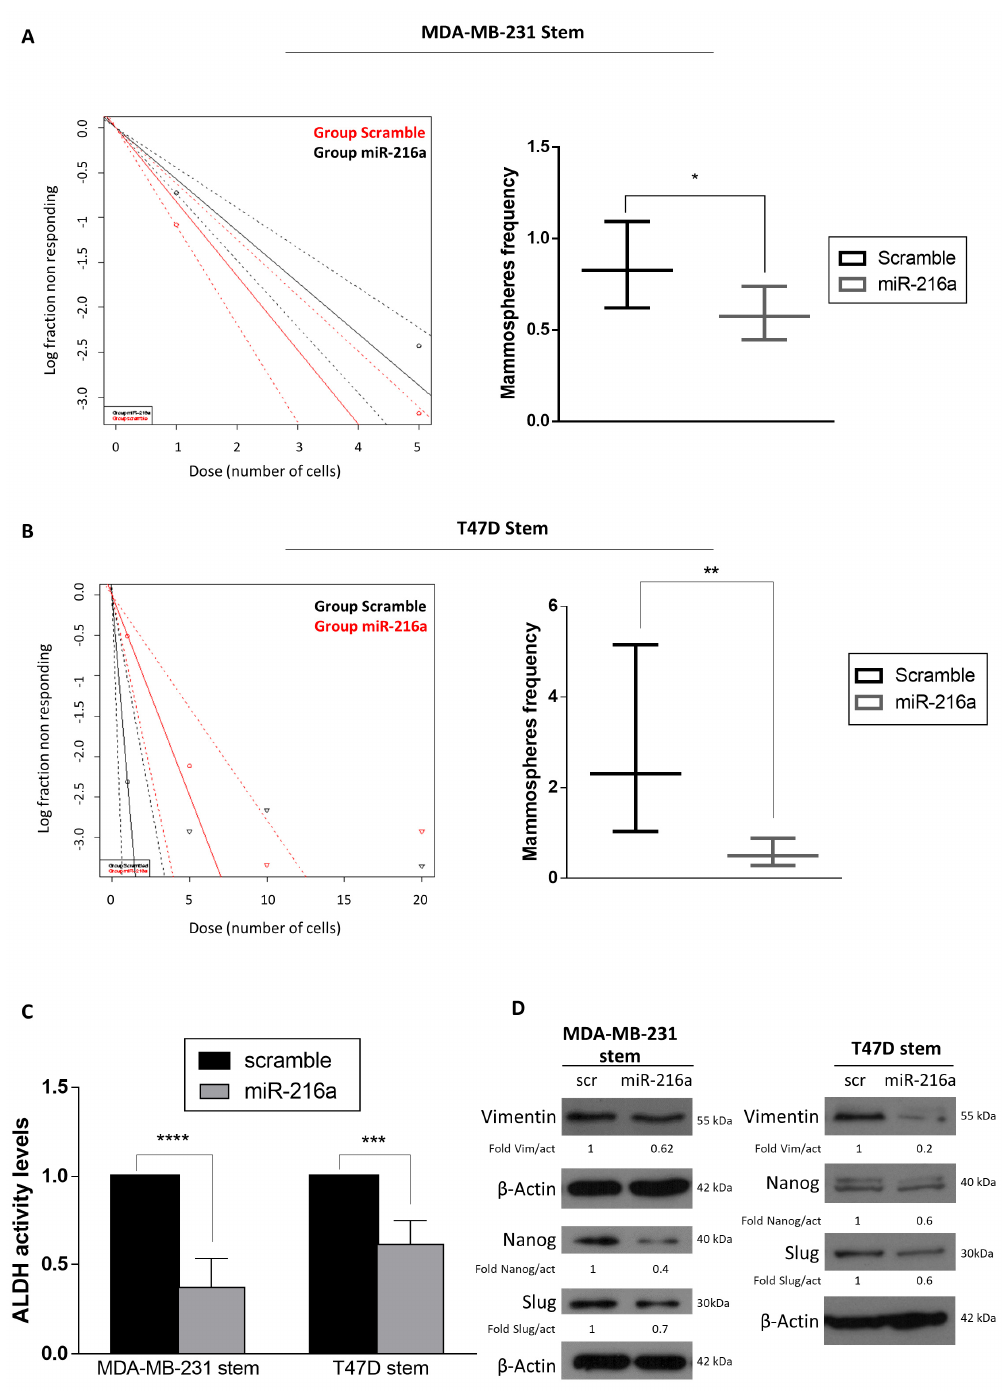
Figure 2. MiR-216a-5p regulates BCSC phenotype. ( A , B ) MiR-216a overexpression decreases the frequency of stem cells in MDA-MB-231 and T47D cultures, as assessed by limiting dilution assay. Significance was calculated using ELDA software. ( C ) ALDH activity decreases after transfection with miR-216a in MDA-MB-231 and T47D stem cells. ( D ) Stemness and EMT markers are decreased after transfection of miR-216, as assessed by Western blotting, in MDA-MB-231 and T47D stem cells. Data are mean values ± SD of three independent experiments. Significance was calculated using Student’s t-test. *, p ≤ 0.05; **, p < 0.01, ***, p < 0.001, ****, p <